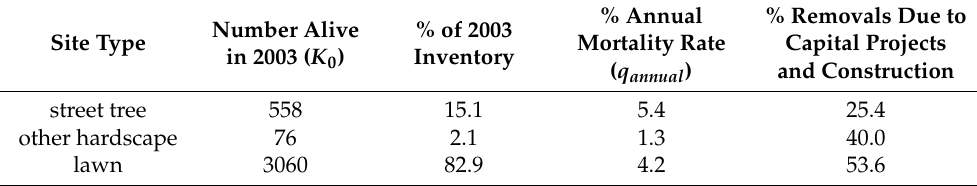
Table 3. Annual mortality rates by site type (for all 3694 trees in 2003).